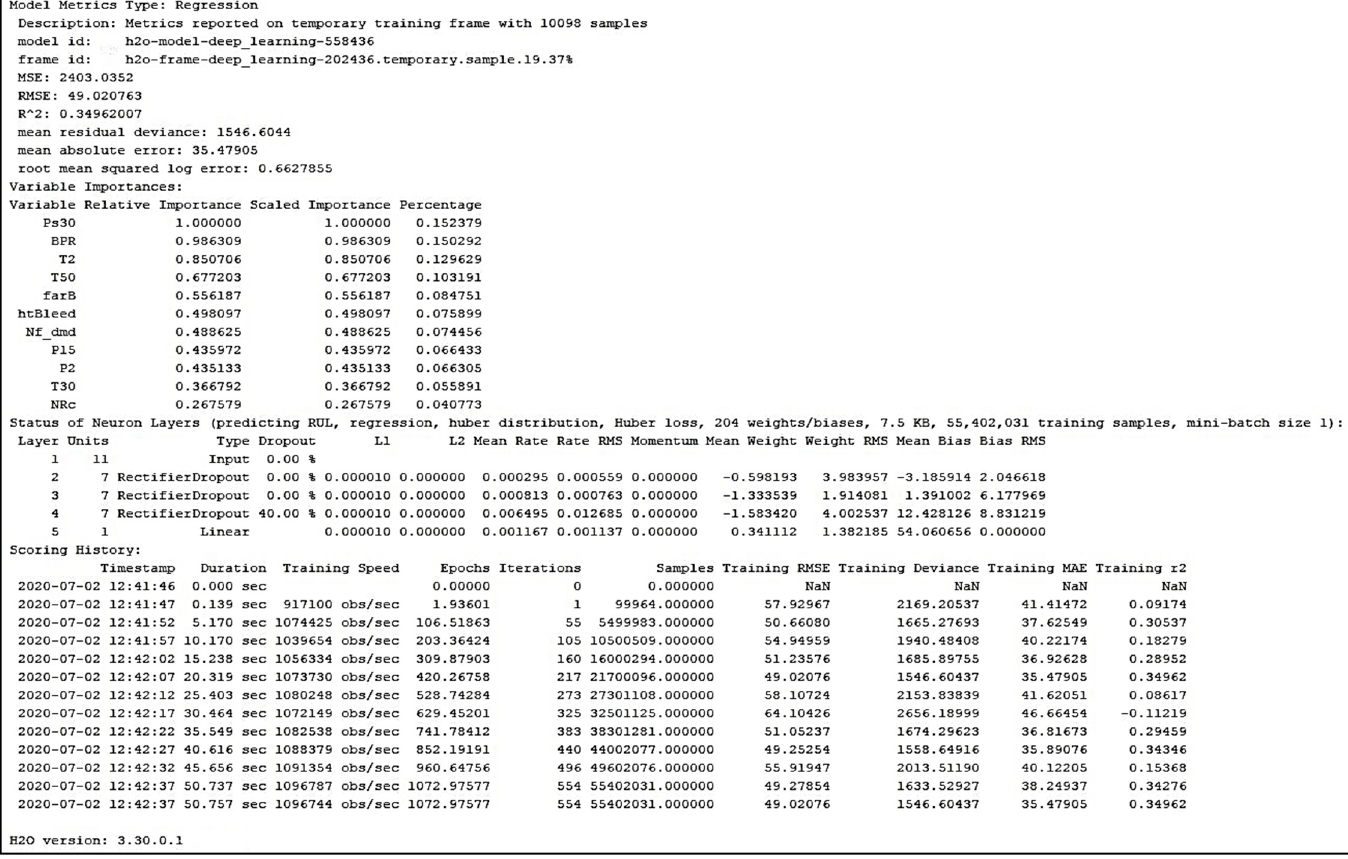
Figure A1. Final Proposed Evolutionary DNN Model description.